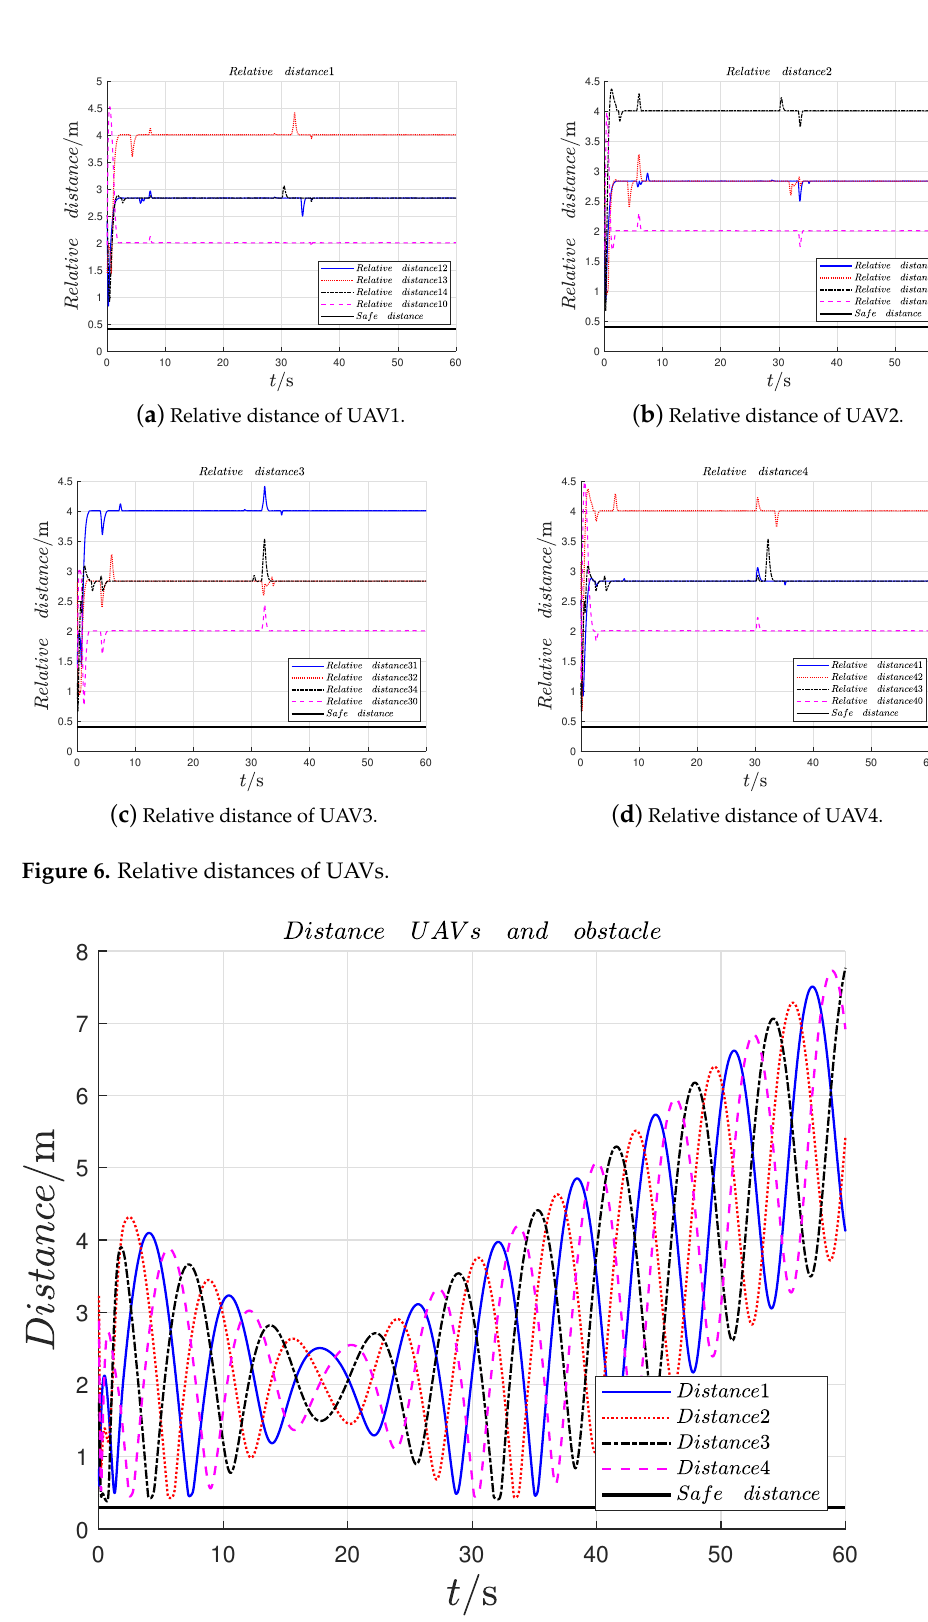
Figure 7. Relative distance between UAVs and